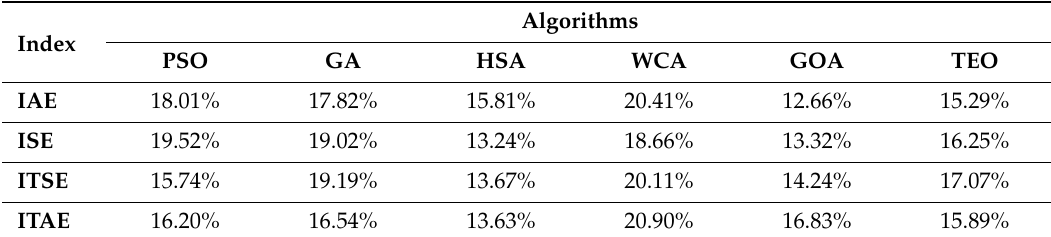
Table 7. The computational time efficiency (CTE) of each algorithm over the four indices.